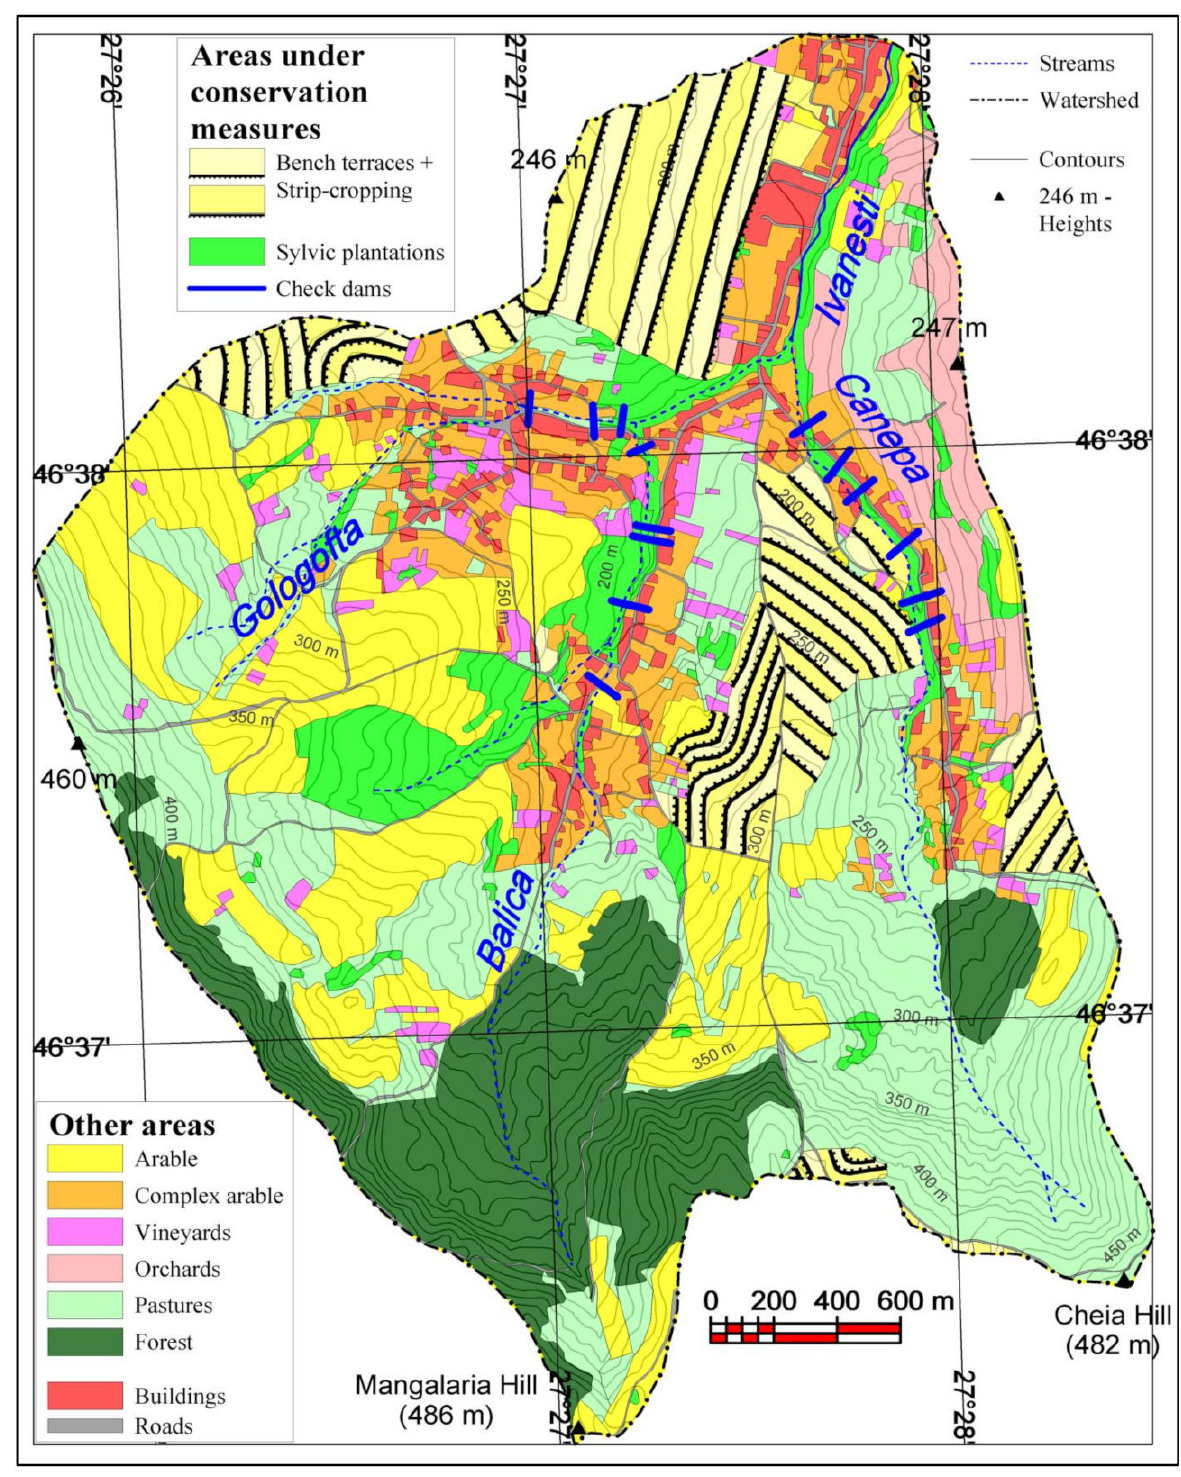
Figure 6. Map of the current land use & land cover in the Ivanesti sub-catchment. Among the conservation measures implemented during 1970–1989, those presented on the map are still